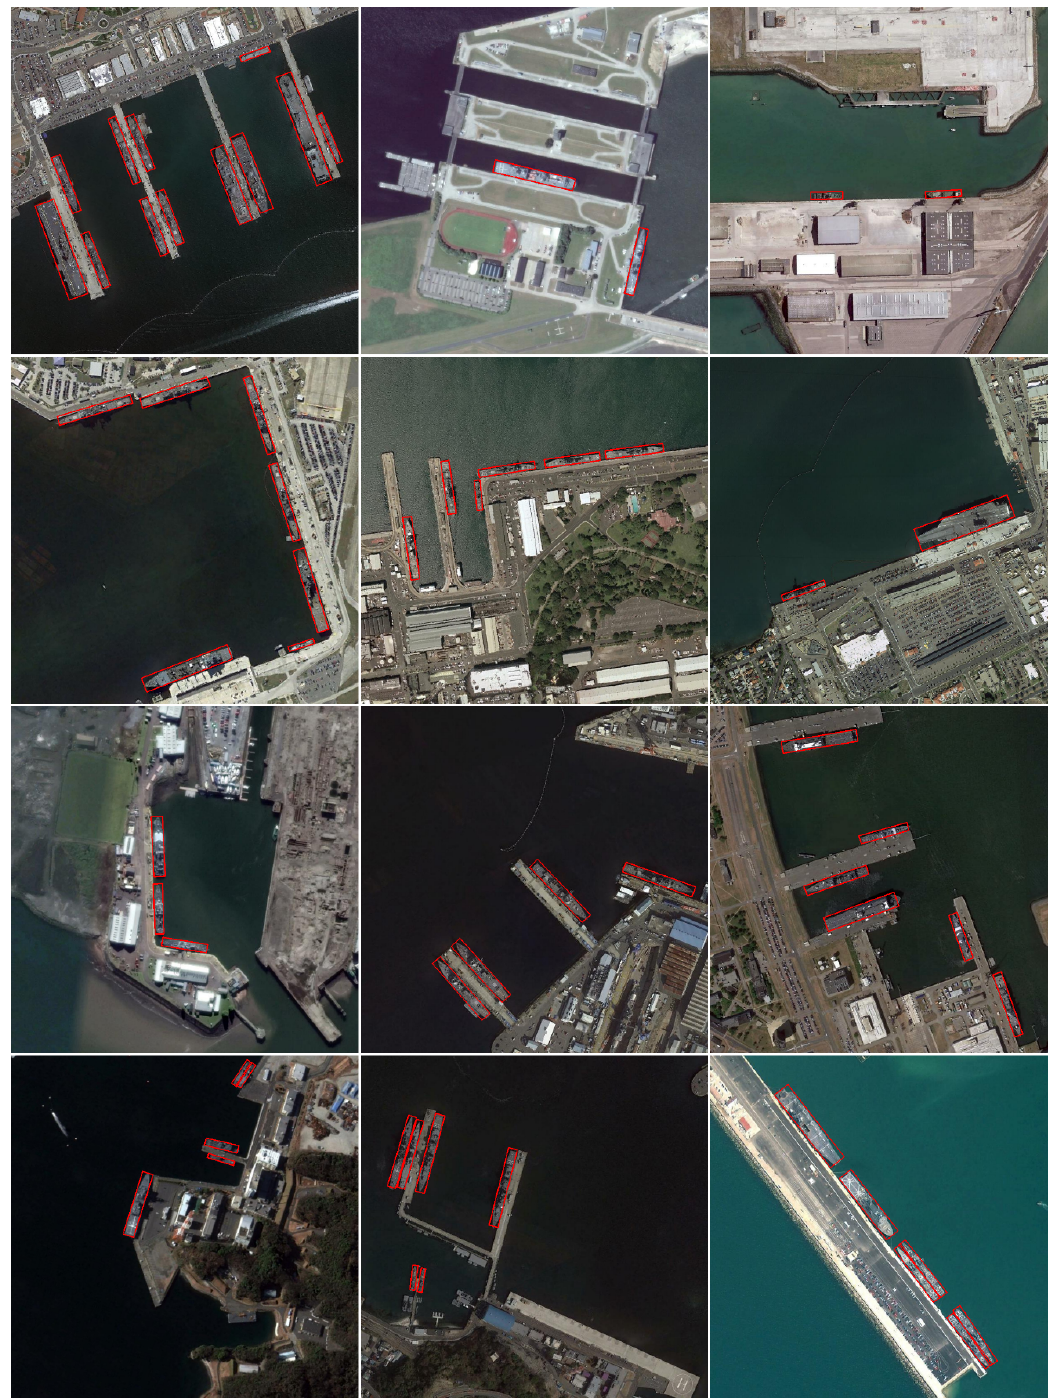
Figure 12. Visualization of detected ships with the proposed method on our